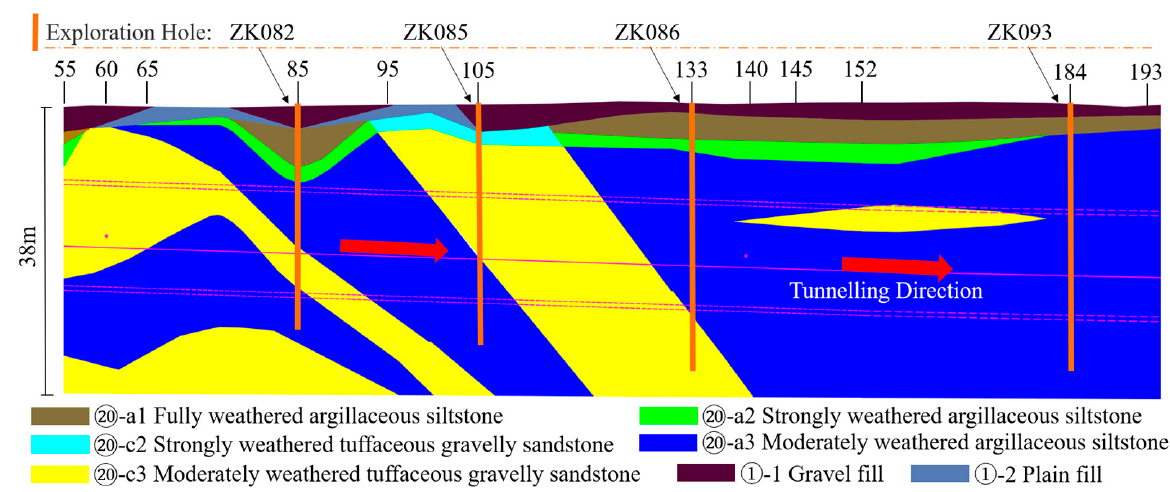
Figure 2. Longitudinal geological profile of the interval tunnel.